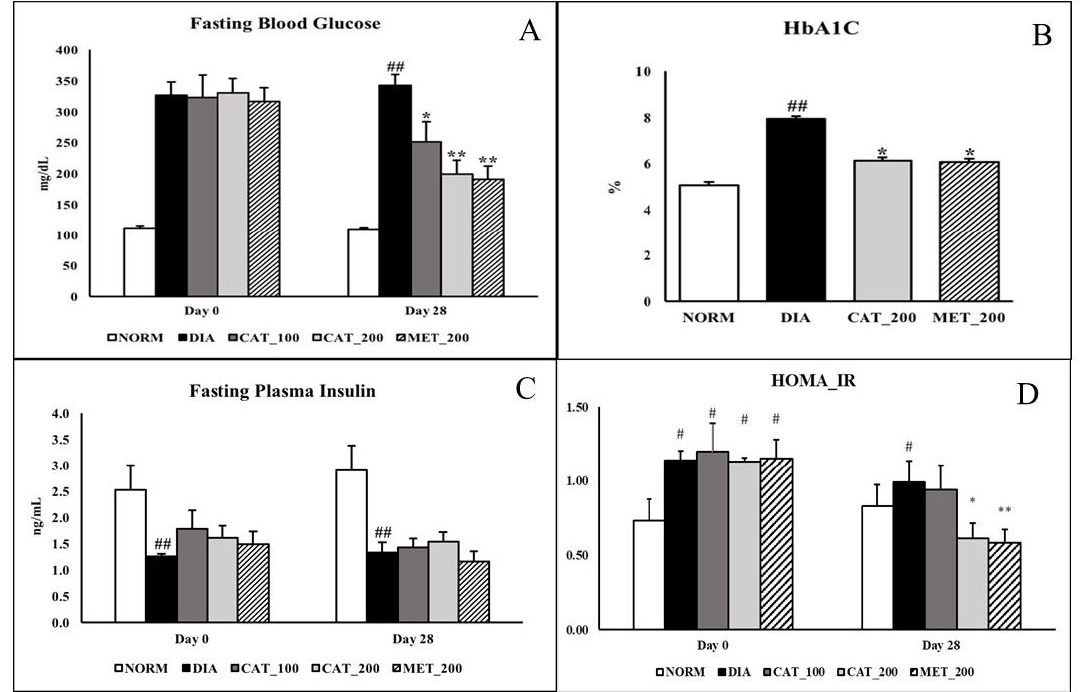
Figure 1. Effect of catalpol and metformin on FBG, plasma insulin, HbA1C and HOMA_IR index. ( A ) FBG at baseline (Day 0) and 28 days; ( B ) HbA1C on day 28; ( C ) Plasma insulin level; ( D ) HOMA_IR